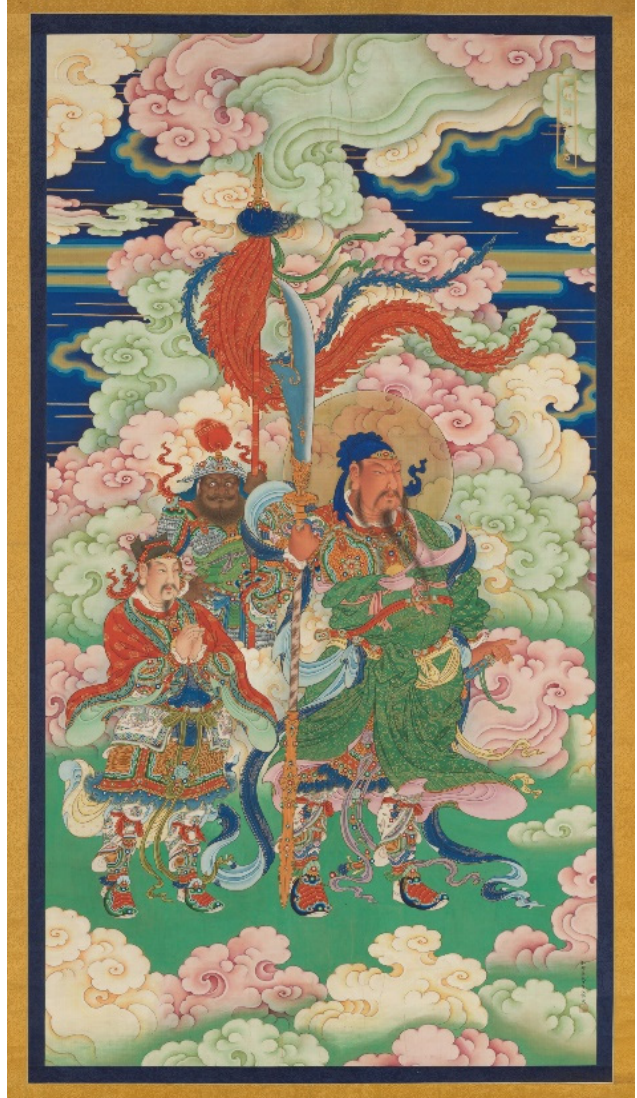
Figure 5. Unidentified artist. Guandi , ca. 1700. Qing dynasty (1644–1911). Hanging scroll (from a set of images for shuilu 水陸 rituals); ink, color, and gold on silk. 173 cm × 92.6 cm. Metropolitan Mu- seum of Art (2001.442), purchased with the B. Y. Lam Fund and Friends of Asian Art Gifts, in honor of Douglas Dillon, 2001. Image licensed under Creative Commons, reproduced with permission from the Metropolitan Museum of Art, New York.